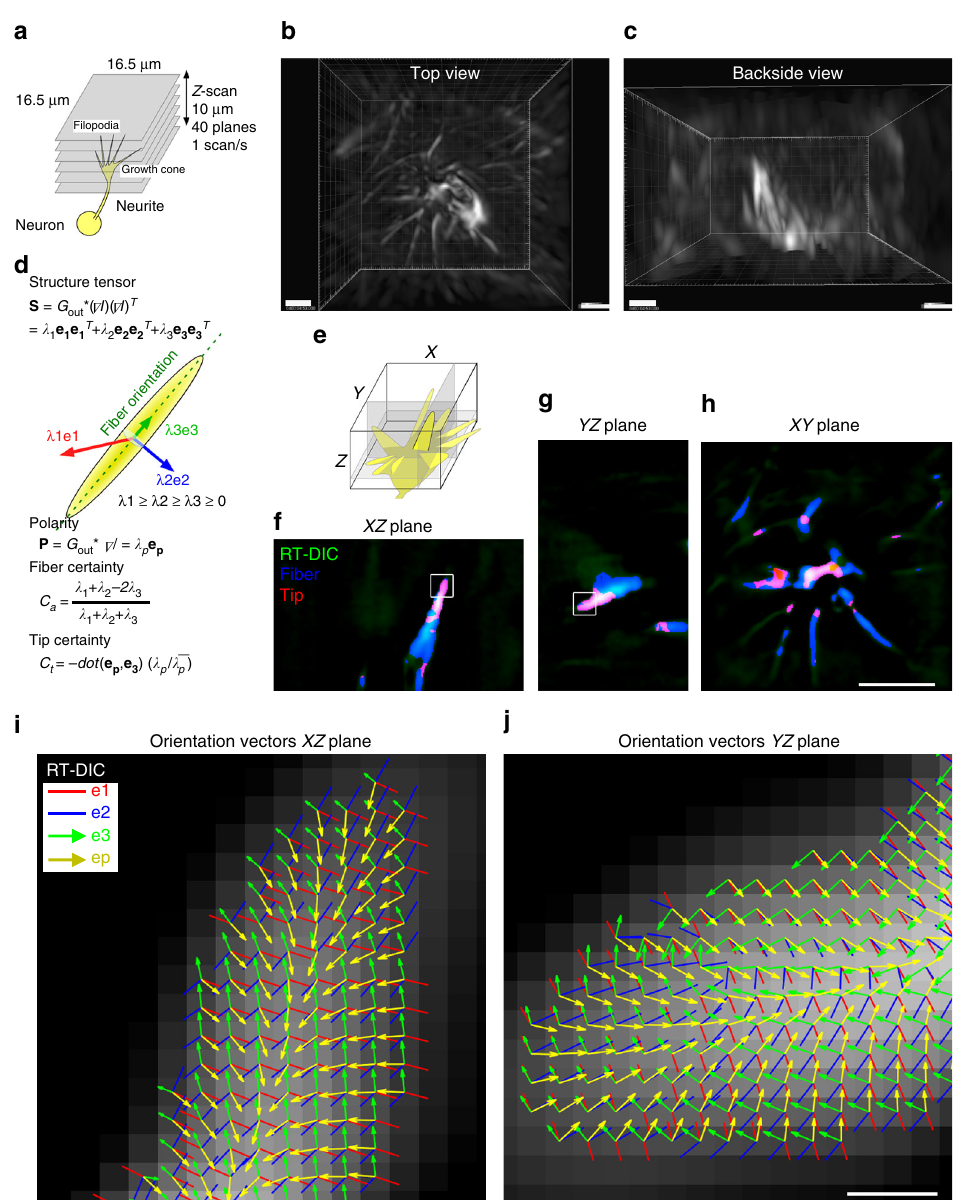
Fig. 3 3D RT-DIC time-lapse imaging and morphological analysis of the growth cone. a Set-up for acquisition of time-lapse and Z-scanned DIC images. b , c Top b and backside c views of rendered RT-DIC images. d Voxel-wise geometric feature estimation with the structure tensor. Structure tensor S , which is calculated from the cross product of the gradient of intensity I and smoothing with a Gaussian Gout , is eigen decomposed. Eigenvector e3 with the lowest eigenvalue λ 3 represents the fi ber orientation. Polarity vector P , which is calculated from the smoothed gradient, is represented by the magnitude λ p and the orientation ep . Fiber certainty Ca is given by the eigenvalues. Tip certainty Ct is given by ep , e3 , λ p and its mean . e A schematic representing cross sectioning of a 3D RT-DIC image stack with XZ , YZ , and XY planes (gray). f – h Cross-section images of RT-DIC intensity (green) were overlaid with fi ber (blue) and tip (red) indices. i , j Distribution of the tensor-derived eigenvectors and the polarity vector at the fi lopodial tip (boxed regions in f and g ). Data from cell #2. Scale bars, 2 μ m at lower left corners of b and c , 5 μ m in h for f – h , 200 nm in j for i and